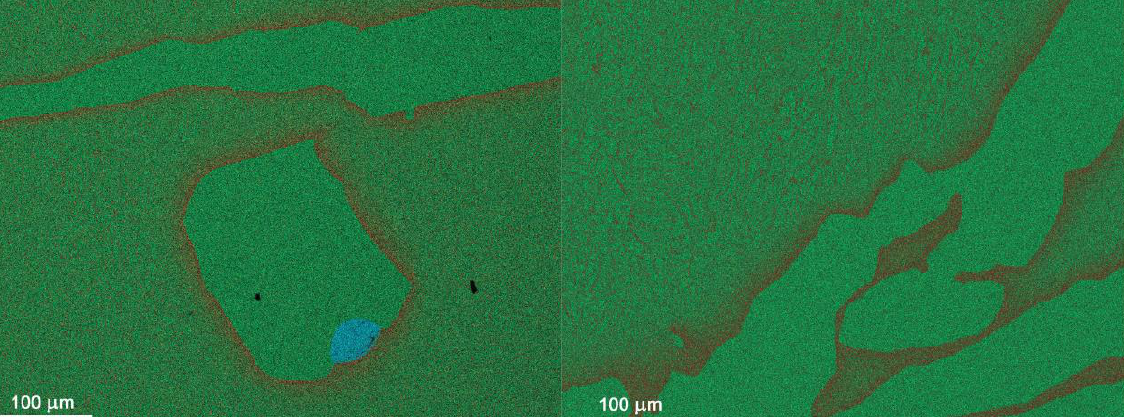
Figure 8. X-ray maps for Fe (green), Ni (red) and S (blue) of two different areas of the Oglat Sidi Ali meteorite; a marked Ni enrichment is visible at the kamacite – taenite border.